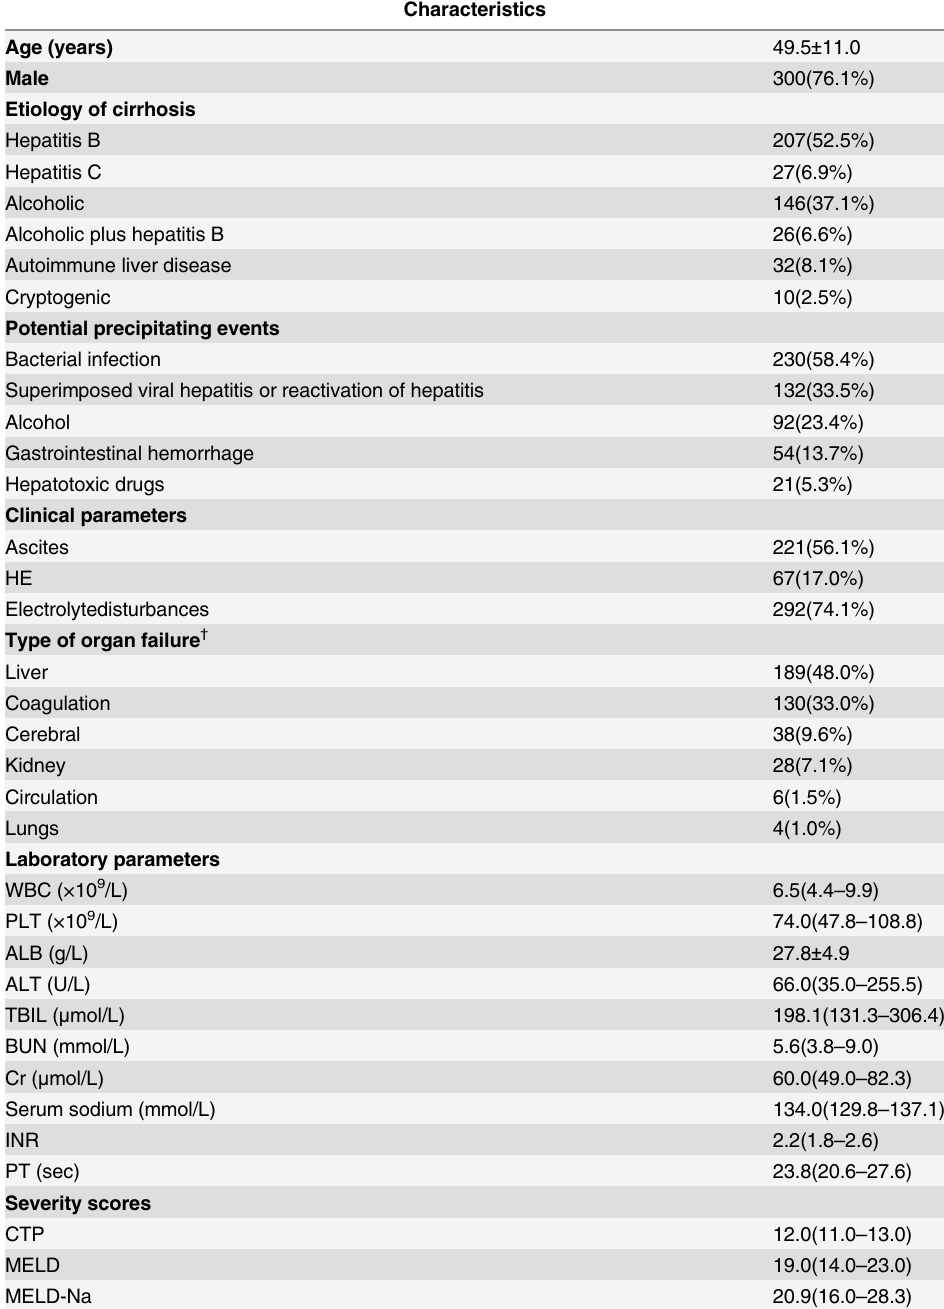
Table 1. Characteristics of eligible patients at